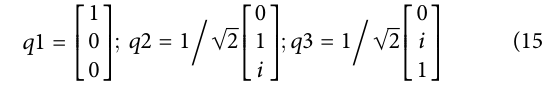
Raney et al. (2012) proposed the m − χ decomposition for the CP SAR datasets. This decomposition approach requires two parameters, namely, degree of polarization m and degree of ellipticity χ . The chi ( χ ) is an essential parameter to describe the even versus odd backscattering signal. The degree of circularity of the polarizing ellipse is determined by utilizing the stokes parameter ( Eq. 21 ).